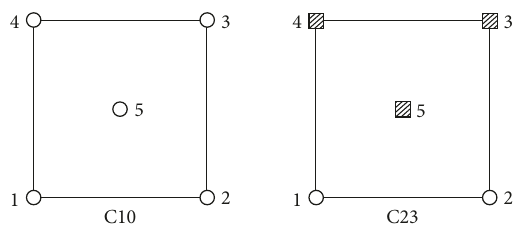
a , and (c) C3 with μ b .